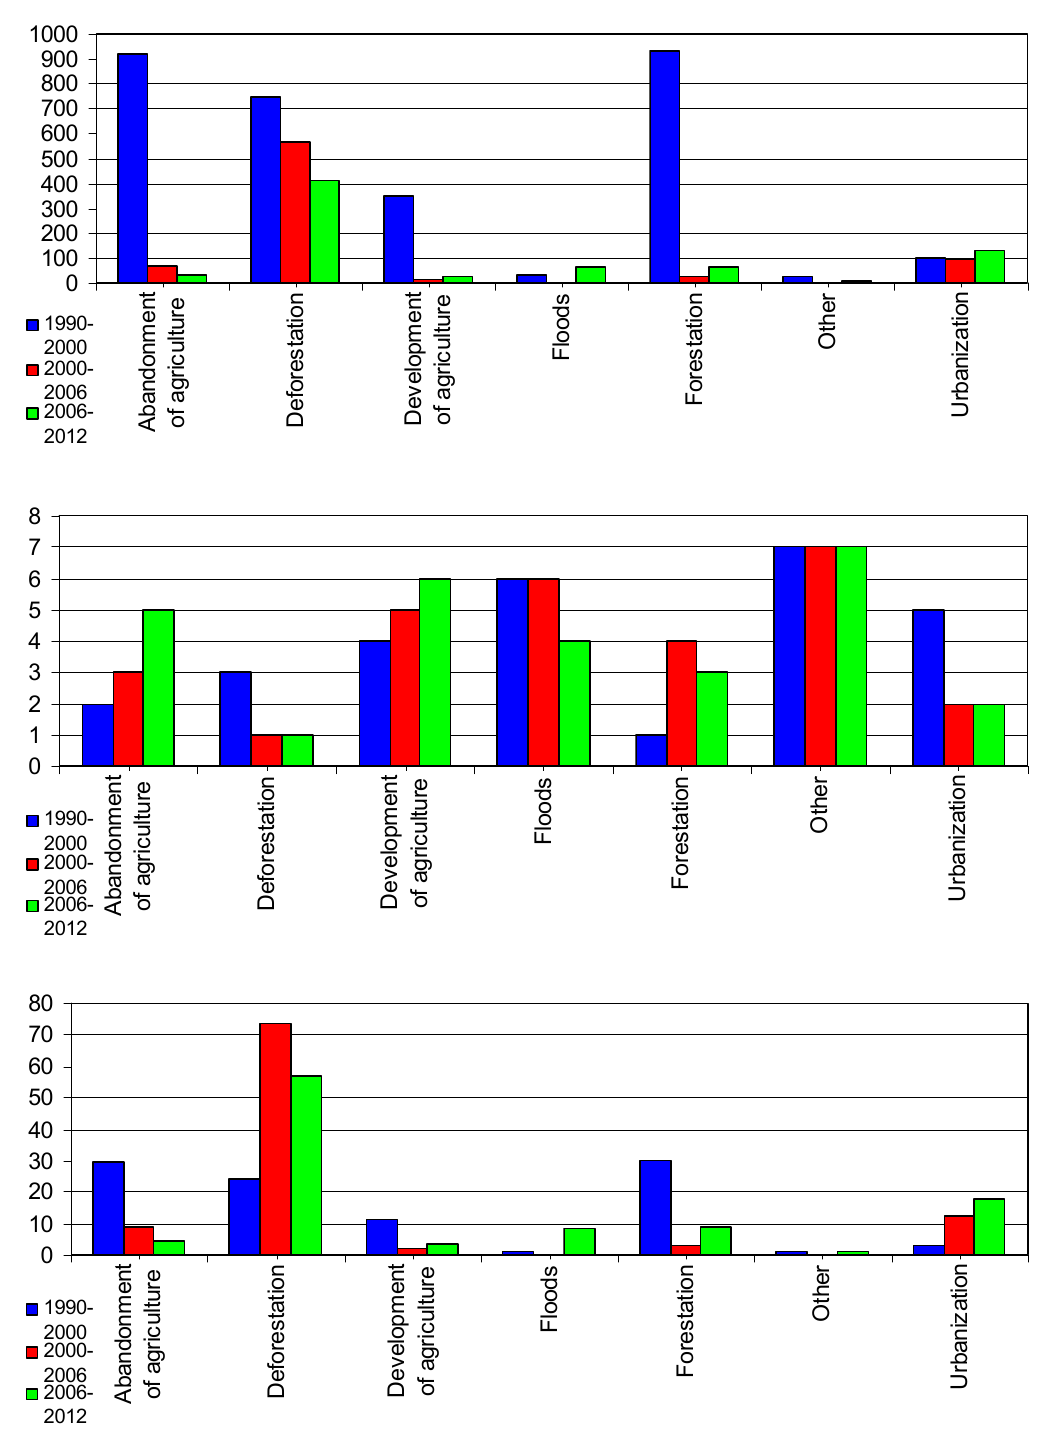
Figure 2. Distribution of the total area a ff ected by di ff erent transitional dynamics associated to 1990–2012 land cover and use changes in Romania, using CORINE data. The three images reflect the raw data (in km 2 ) ( top ), ranked data ( middle ) and percentage data ( bottom ). The ranking of data was performed using the ascending